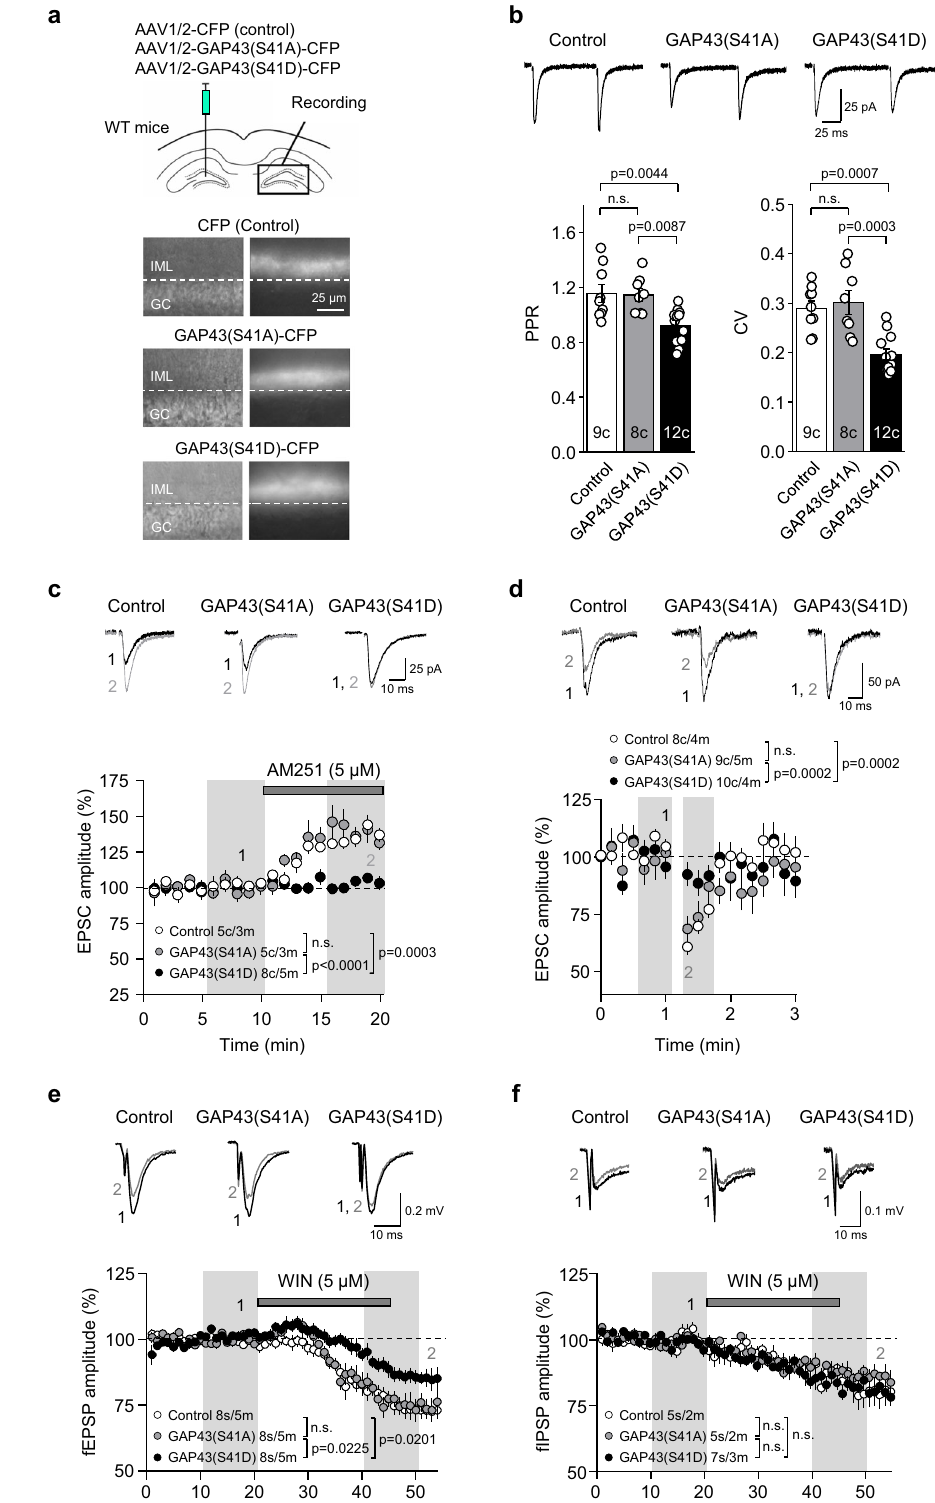
(Fig. 5a). Cre recombinase activity was con fi rmed by the reduction of GAP43 labeling at infected MC axon boutons in IML-containing con- tralateral hippocampal sections (Fig. 5b). Four weeks post-injection, whole-cell patch-clamp recordings were performed from GCs and EPSCs (o-EPSCs) were evoked by optically stimulating MC axons in the IML of the contralateral DG. GAP43-lacking MC-GC synapses